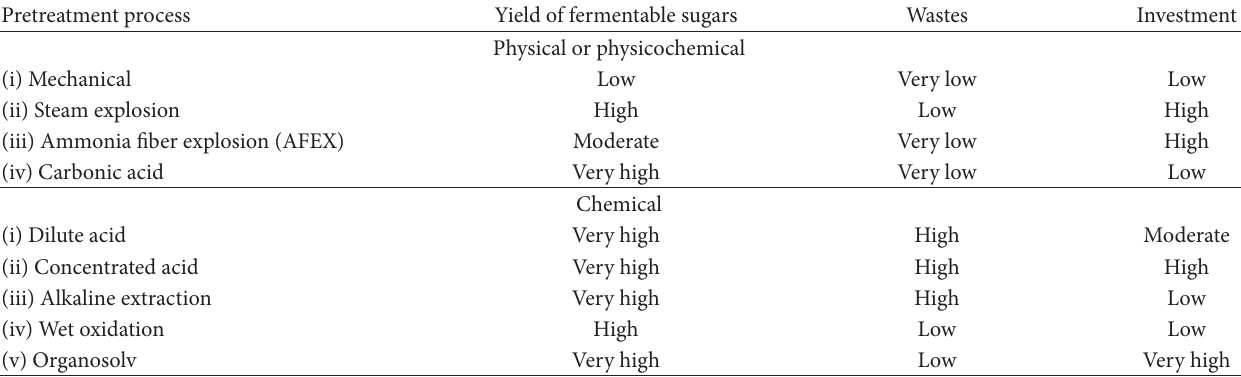
Table 6: Assessment of selected pretreatment processes [15,